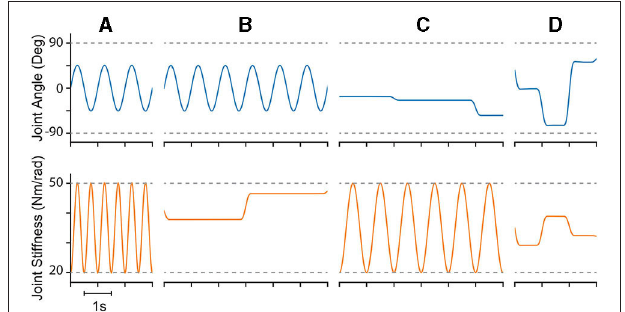
FIGURE 5 | Example plots of four different types of reference trajectories used to test generalizability; (A) sinusoidal joint angle and sinusoidal joint stiffness, (B) sinusoidal joint angle and point-to-point joint stiffness, (C) point-to-point joint angle and sinusoidal joint stiffness, and (D) point-to-point joint angle and point-to-point joint stiffness. For point-to-point tasks, transitions were limited to 0.25 s (2 Hz cutoff) and designed in a way that they were continuously differentiable up to the fourth derivative (i.e., they left and arrived at each point with zero velocities, accelerations, jerks, and